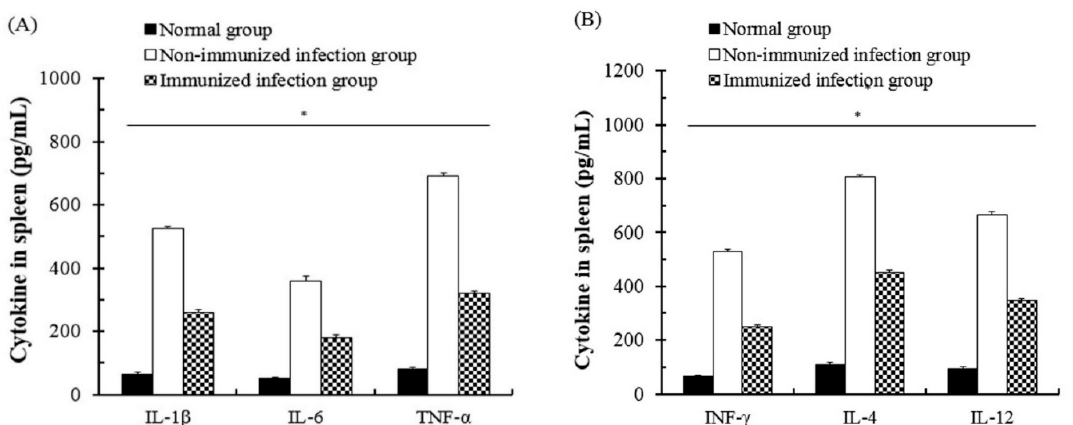
Figure 7. The change of production of cytokines expressed from the spleen. The spleens were collected from mice at 7 days after T. gondii infection (challenge), which was used for detecting the expression of different cytokines (interleukin (IL)-1 β , IL-4, IL-6, IL-12, TNF- α , and INF- γ ). ( A ) IL-1 β , IL-6, and TNF- α . ( B ) INF- γ , IL-4, and IL-12. The groups were divided into three groups as follows: the normal group, the non-immunized group infected with T. gondii (the non-immunized infection group), and the T. gondii infection group immunized with SAG1-VLPs (the immunized infection group).